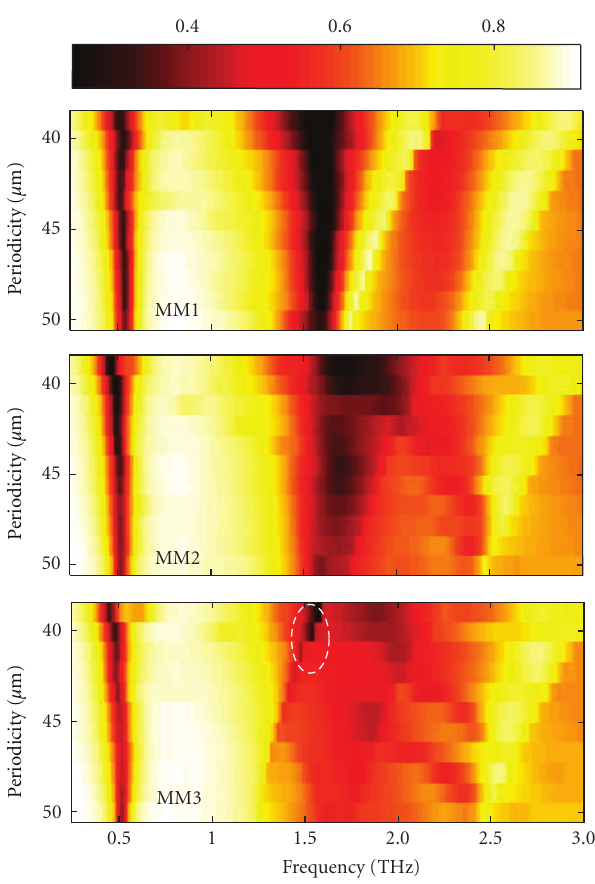
Figure 6: Simulated transmission spectra of the three di ff erently oriented metamaterials with period, P, swept from P = 50 μ m to P = 39 μ